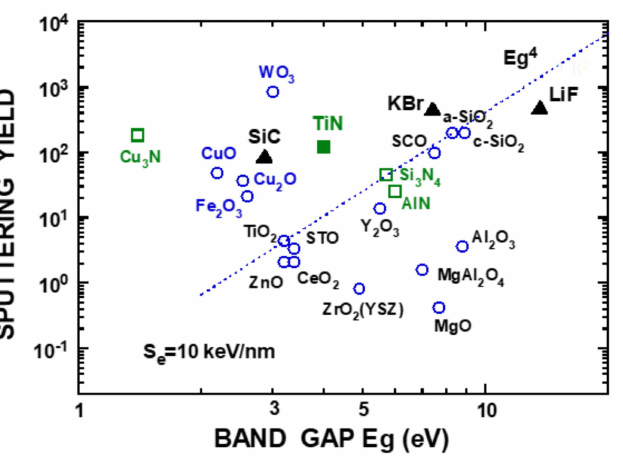
Figure 11. Sputtering yield at S e = 10 keV/nm vs. bandgap. Data from [56], TiN (present result) and LiF data from [62]. Dotted line is a guide for eyes (E g > 3